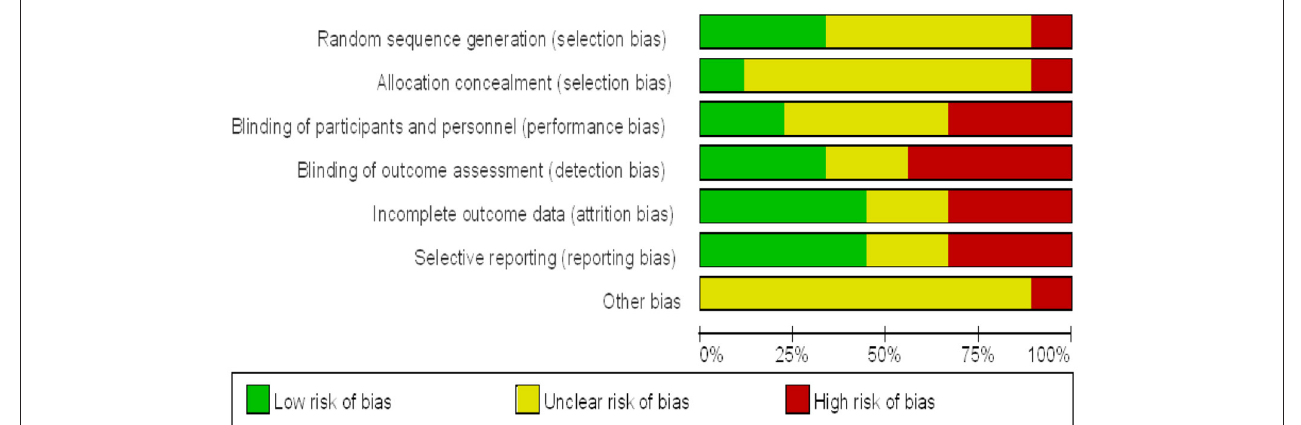
FIGURE 2 | Proportion of risk of bias included in muscle strength studies.